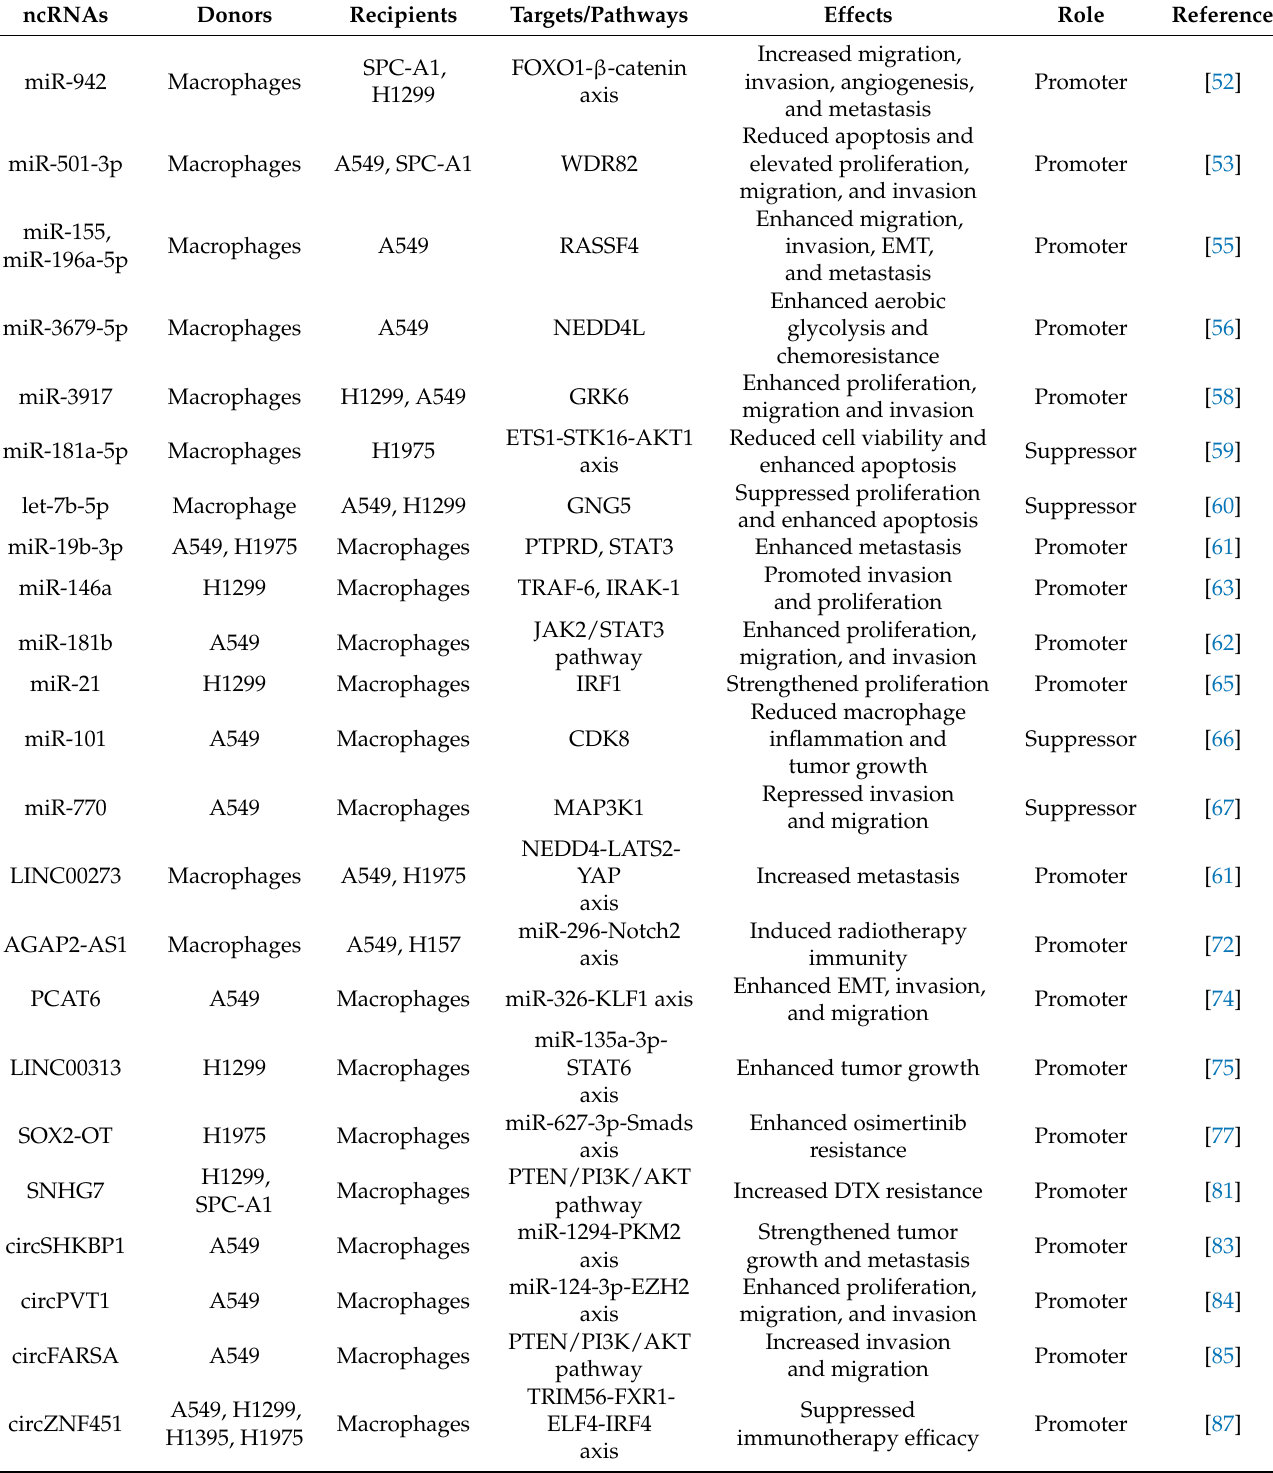
Table 1. Summary of effects of exosomal ncRNAs on lung